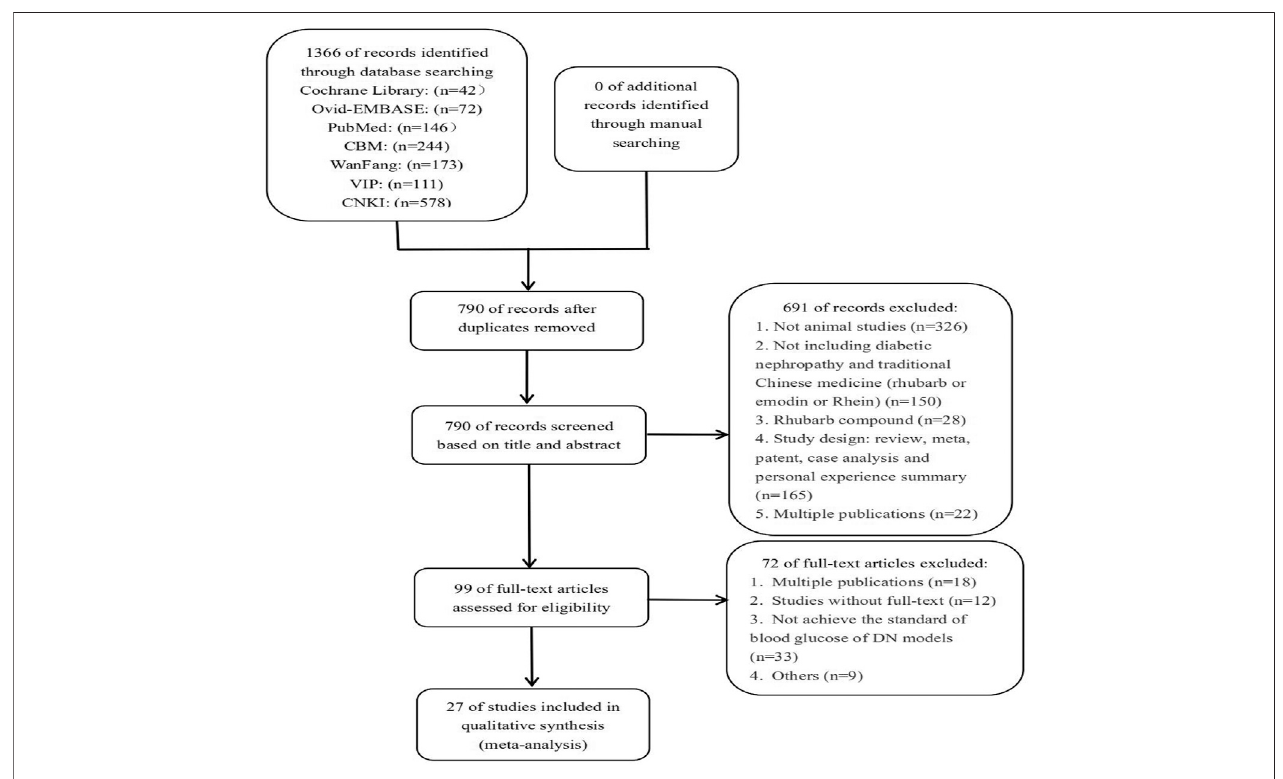
FIGURE 1 | Study fl ow